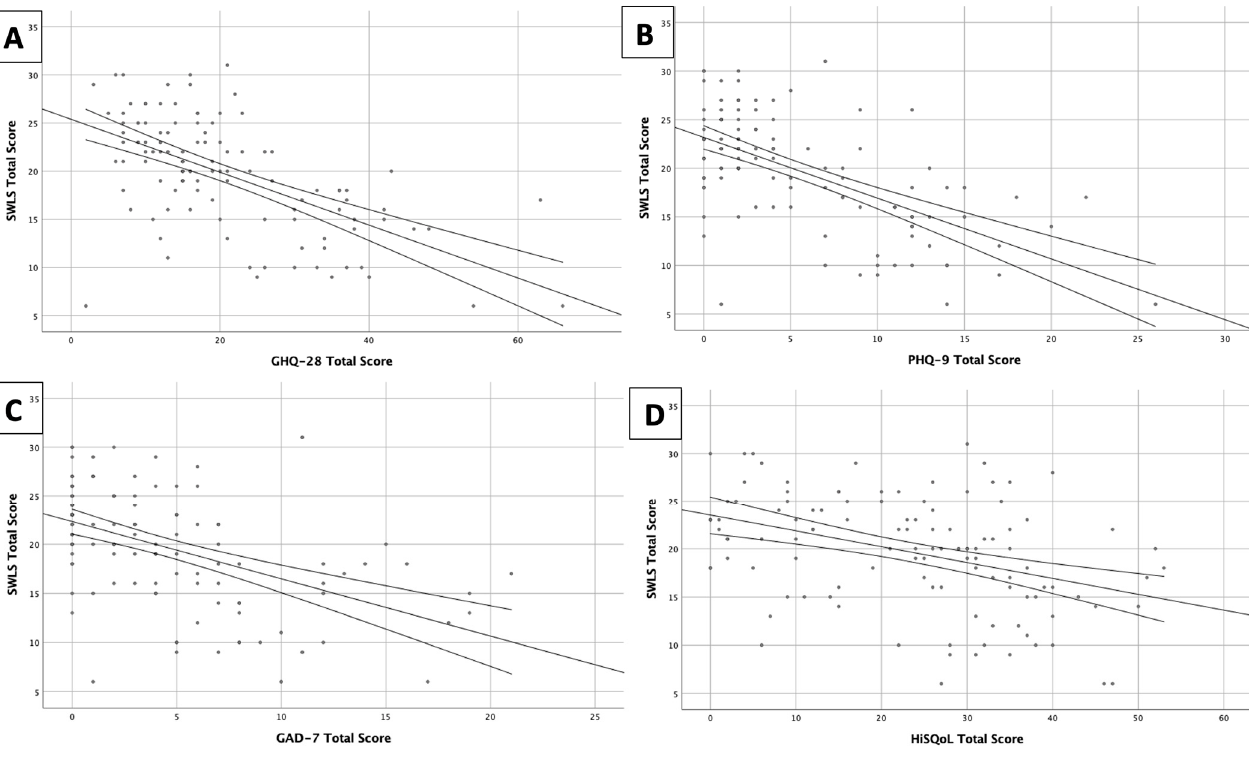
Figure 1. Correlations between satisfaction with life and ( A ) GHQ-28, ( B ) PHQ-9, ( C ) GAD-7 and ( D ) HiSQoL. Each dot represents each patient’s questionnaire score.